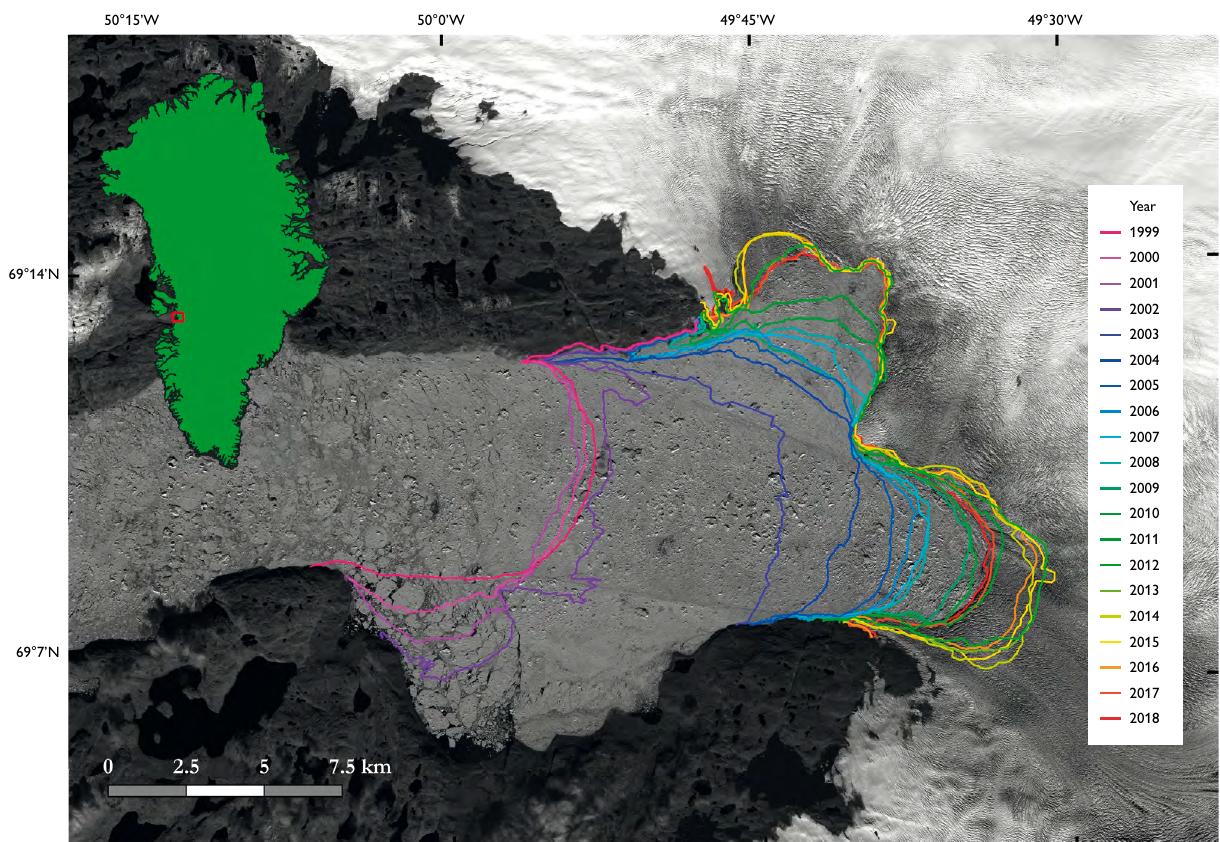
Fig. 3: Evolution of the calving front position of Jakobshavns Isbræ from manually delineated end-of-melt-season calving front lines spanning 1999 to 2018. The background image is from the EU Copernicus Sentinel-2B satellite from 4 September 2018. It is the same image that was used to delineate the 2018 front